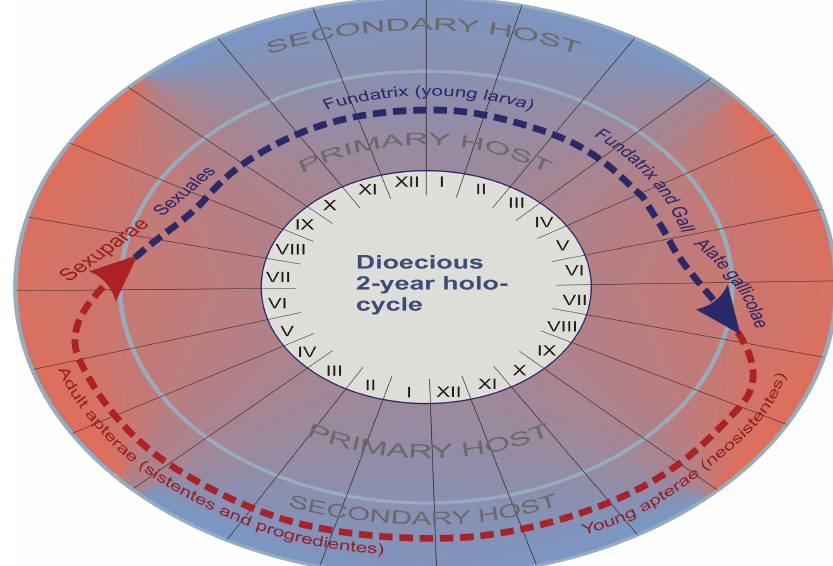
Fig. 5. Dioecious two-year holocycle in Adelgidae, e.g., Adelges laricis (shoot galls on spruce, Picea ; needles of larch, Larix ). All females oviparous. the fundatrix (hatched from a fertilized egg) overwinters as a larva, and induces the formation of a pineapple-like gall on the primary host. All her offspring are alate (gallicolae) and migrate to the secondary host, where they lay eggs on the needles. the aphids hatching move to the twigs where they hibernate as young larvae (the ‘neosistens’ stage). In spring they move back to the needles and become adults (sistentes). their offspring are either alate sexuparae and migrate to spruce, or apterous ‘progredientes’. In autumn the sexuparae fly to spruce and lay eggs which become sexual females and males, which mate. the females then lay eggs out of which new fundatrices